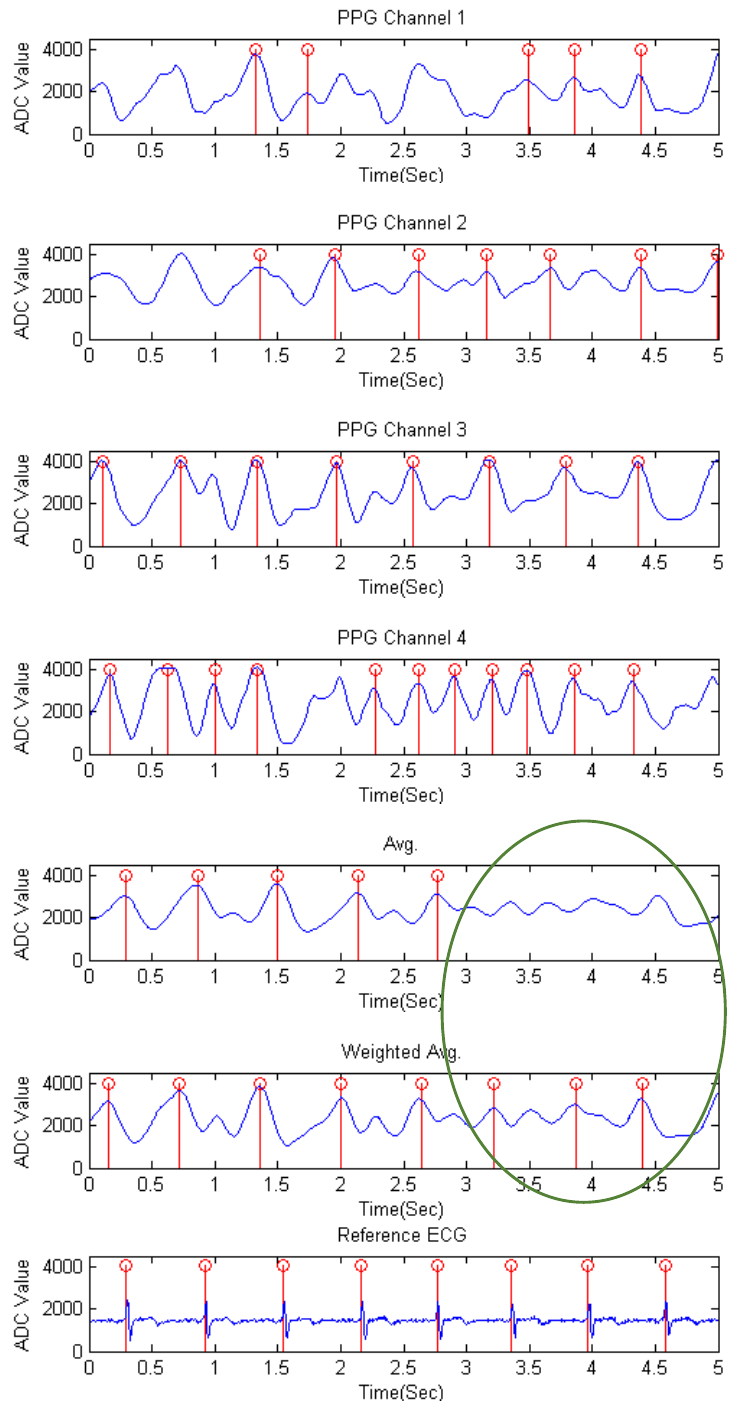
Figure 7. The waveforms of the rapid movement stage of each channel, the mixed signals by the average method and the weighted average method, and the reference ECG signal for subject